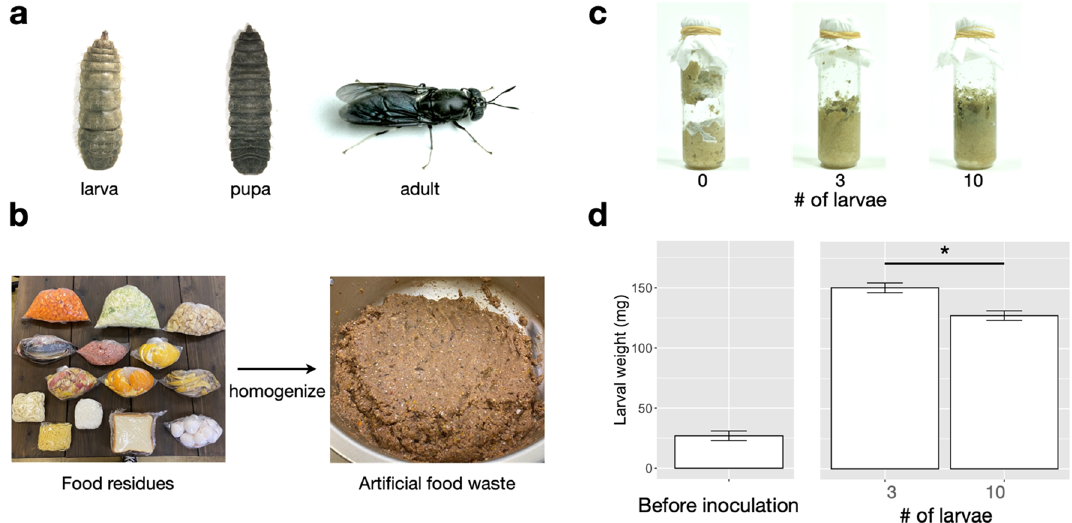
Figure 1. Black soldier fly (BSF) and methods for inoculating the larvae to the artificial food waste. ( a ) Developmental stages of BSF. ( b ) Schematic diagram of the method for preparing artificial food waste. ( c ) Artificial food waste one week after BSF inoculation. ( d ) Larval weights before and after BSF inoculation. Weights of larvae in the 3- and 10-larva vials were compared by using Student’s t -test. *Significant difference ( P <